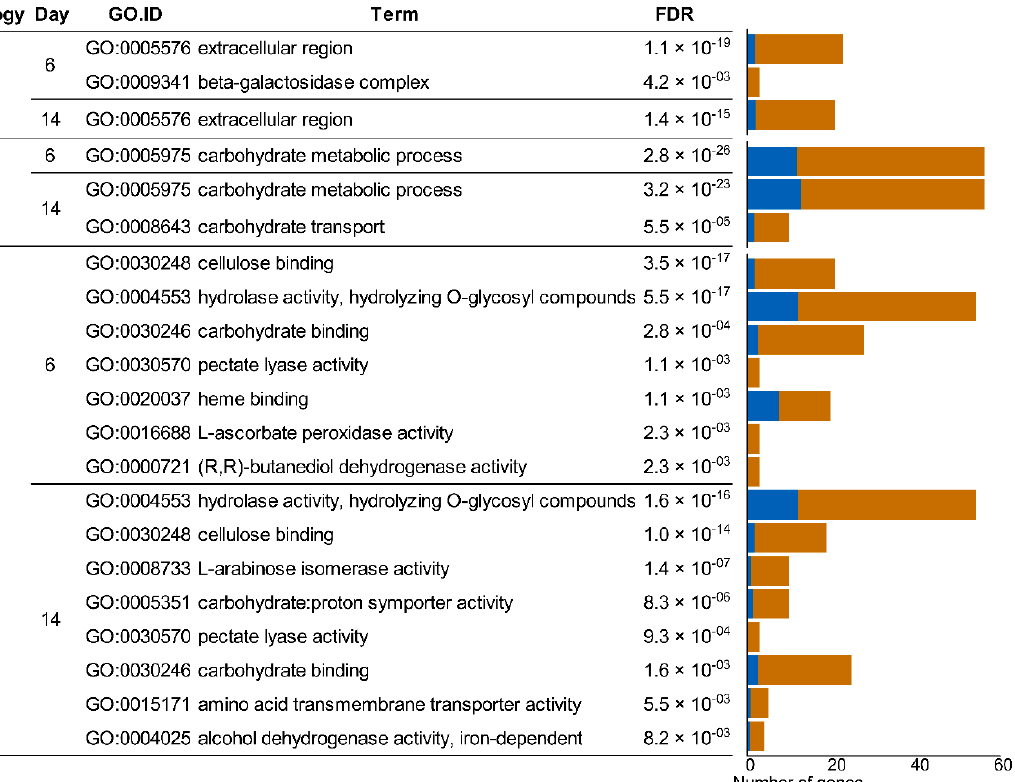
Figure 3. Enrichment of up-regulated genes in P. eryngii when growing on wheat–straw compared with glucose–ammonium medium, clustered by the GO categories: CC, “Cellular Component”; BP, “Biological Process”; and MF “Molecular Function”. The bar chart shows the expected (blue) and observed (brown) number of up-regulated genes of each GO term.